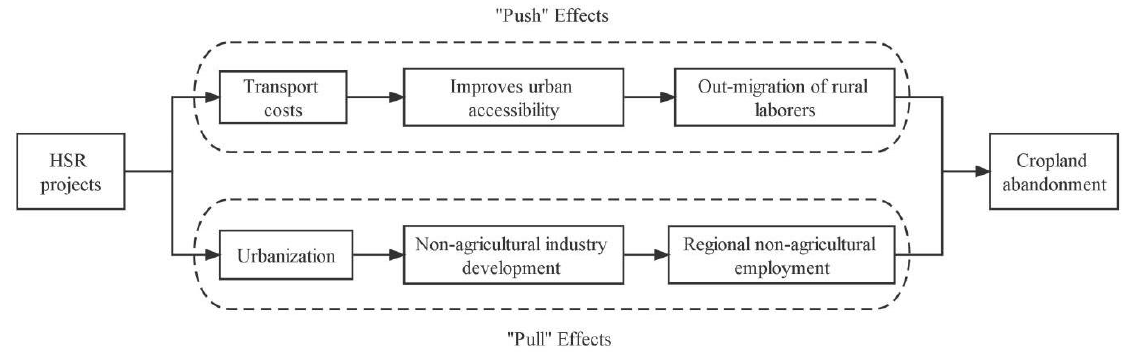
Figure 1. HSR project impact mechanism on cropland abandonment.